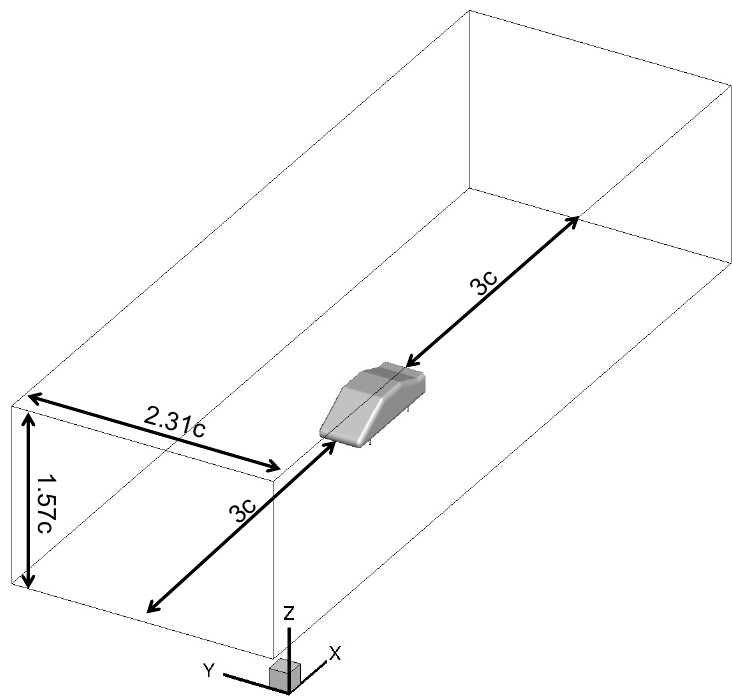
Figure 4. Computational domain.